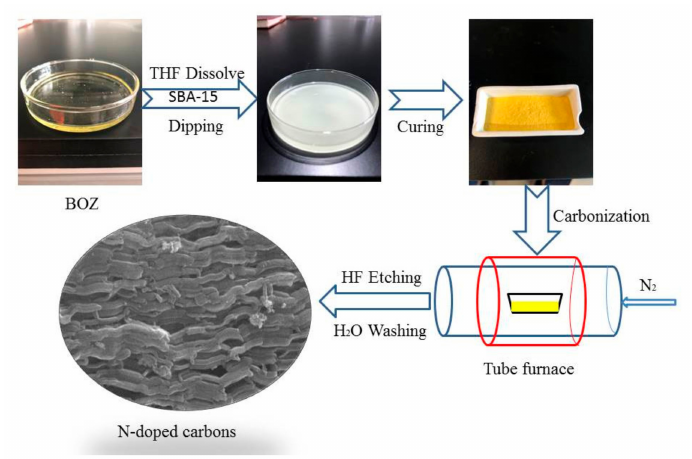
Figure 1. The preparation process for N-doped carbons using benzoxazine as precursor. BOZ: benzoxazine, HF: hydrofluoric acid.